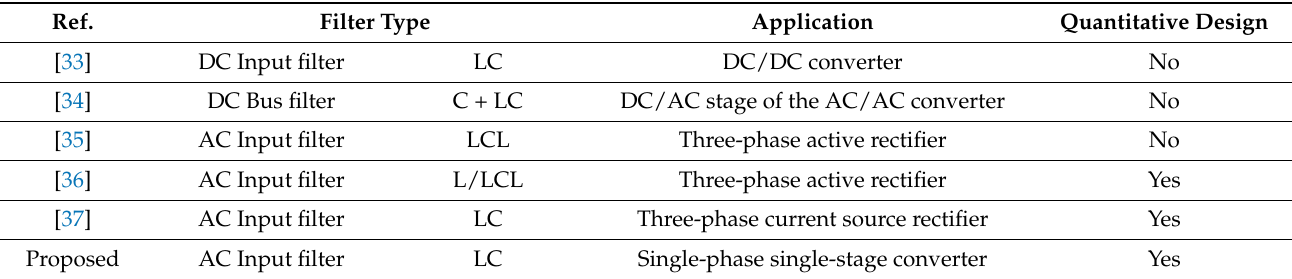
Table 1. Different filter design